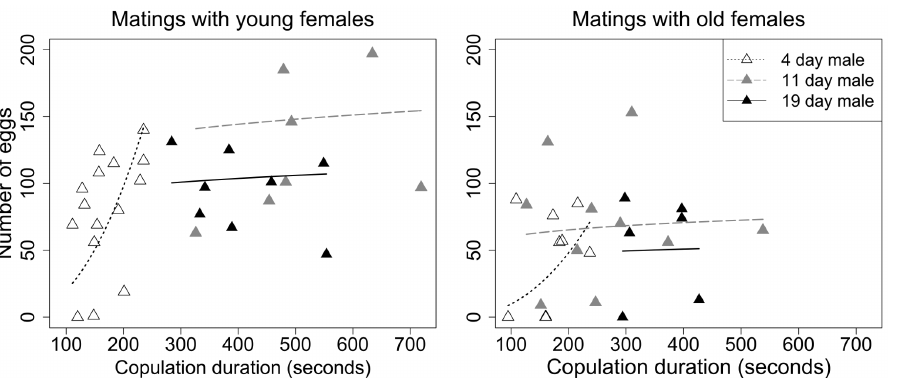
Figure 2. Effect of copulation duration on the number of eggs laid by females in the first two days after mating. Regression lines obtained from the second gamlss models are plotted. Empty symbols and dashed lines represent matings of 4-day old males; grey symbols and solid grey line depict matings of 11-day old males; filled black symbols and solid black line show matings of 19-day old males.